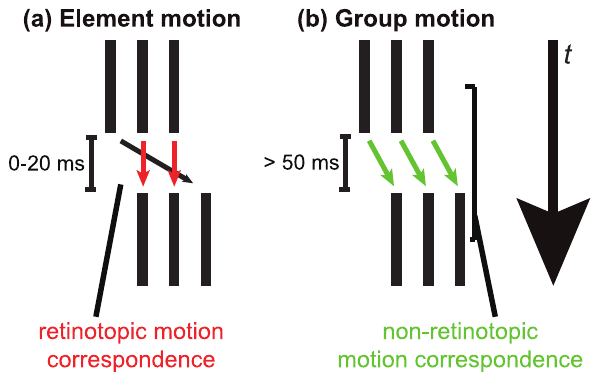
Figure 1. A schematic explanation for the perceived motion correspondence in the Ternus display: (a) element motion and (b) group motion. The small arrows represent the correspondences of visual elements between temporal